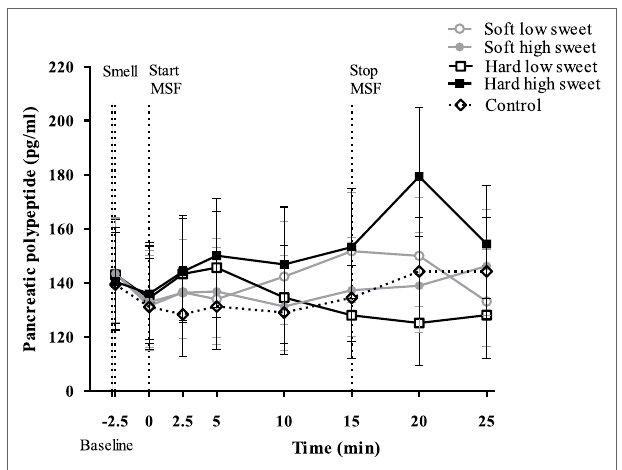
FigUre 6 | Geometric mean ± 95% CI pancreatic polypeptide concentrations (pg/ml) corrected for baseline concentration over time per treatment and control condition. No significant differences were found between treatments and control condition at any of the time points ( p = 0.72).